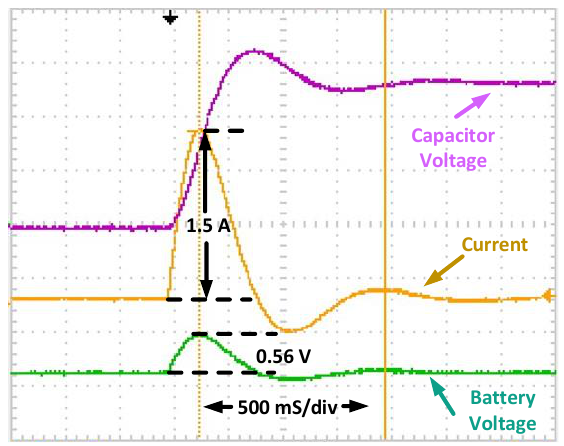
Figure 10. The waveform of the LC resonant at 56 Hz. Figure 11 shows the resistance data of B 1 , B 2 , and B 3 . The data are obtained by putting the LIBs inside the thermal chamber to control the temperature. Then, the LIBs are connected to the LC resonant tank and the BMS. The temperature is set from − 20 to 40 ◦ C with an interval of 5 ◦ C. The data show that R ohm and R ct are affected by temperature. At